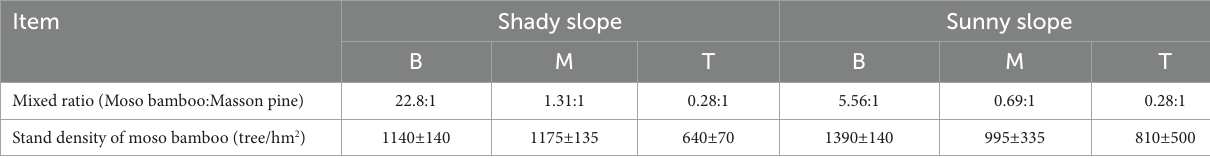
TABLE 1 Differences in bamboo standing degree of bottom slope, middle slope and top slope in different slope directions. Item Shady slope Sunny slope B M T B M T Mixed ratio (Moso bamboo:Masson pine) 22.8:1 1.31:1 0.28:1 5.56:1 0.69:1 0.28:1 Stand density of moso bamboo (tree/hm 2 ) 1140±140 1175±135 640±70 1390±140 995±335 810±500 B, bottom slope; M, middle slope; T, top